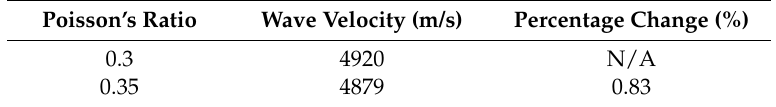
Table 8. Parametric study of Poison’s ratio for isotropic material model.